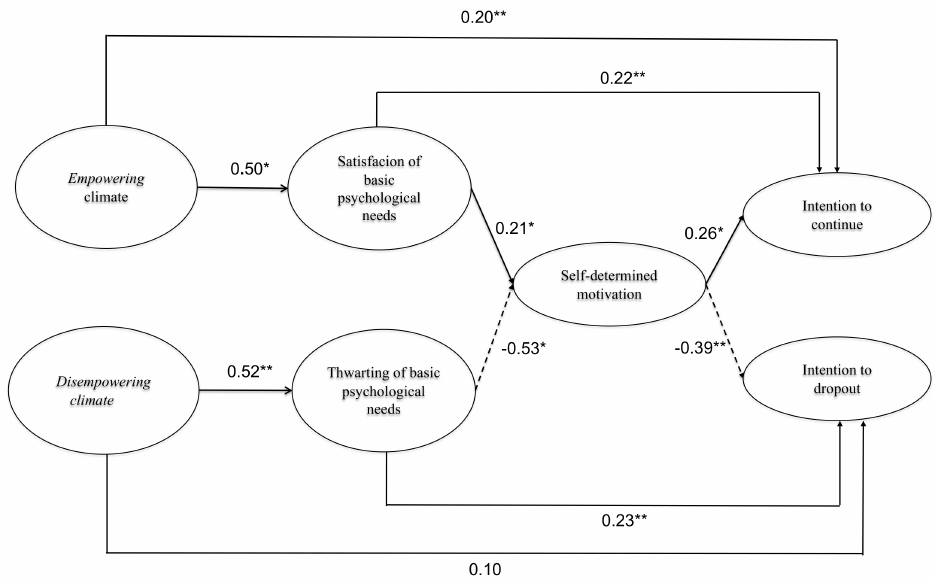
Figure 2. Structural Equations Model of the sequence Climate empowering and disempowering ®Satisfaction/Frustration of Basic Psychological Needs ®Self-Determined Motivation ®Future in- tentions to participate (M2). Note. This structural equation model predicts future intentions to participate from the perception of empowering and disempowering climates generated by the coach, with mediating effects of satisfaction/thwarting of basic psychological needs and self-determined motivation. Solid lines represent positive relationships; dashed lines represent negative relationships; bold lines (solid or dashed) represent significant indirect relationships. Standardized coefficient values are offered ( β ). * p < 0.05. ** p <